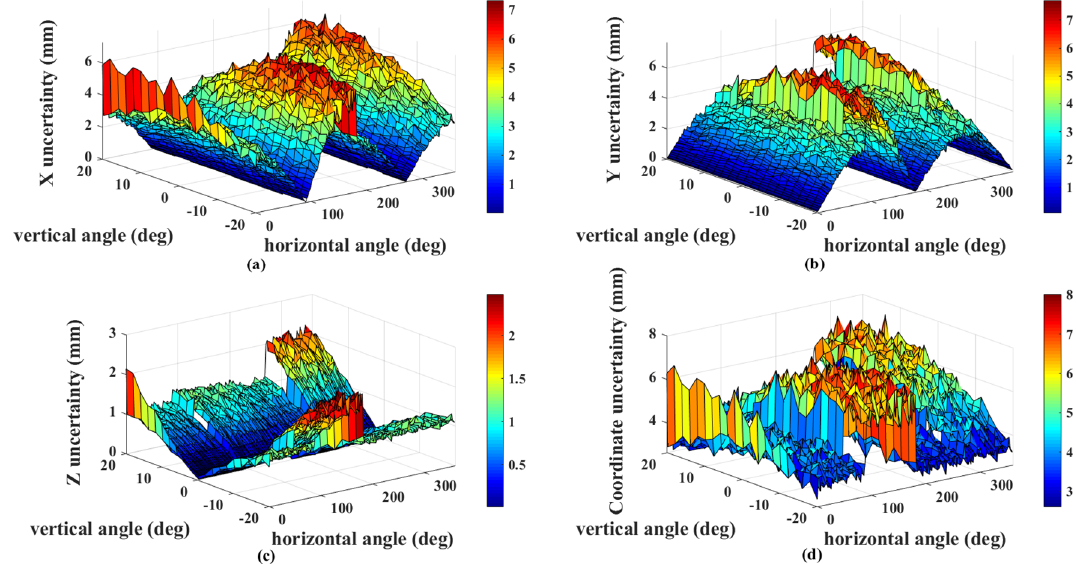
Figure 6. Error simulation in radius of 10 m: ( a ) the uncertainty of the X-axis error in space; ( b ) the uncertainty of Y-axis error; ( c ) the Z-axis uncertainty; ( d ) the uncertainty of combination error from three axes.